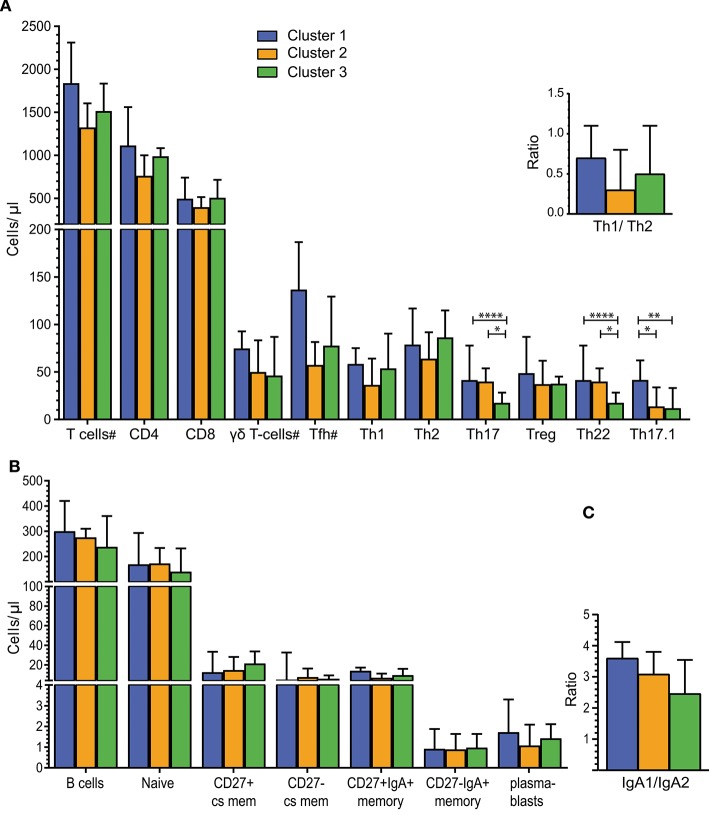
Alterations in Th cell subsets in individuals with distinct intestinal microbiota. (A) Absolute numbers of total T cells and T-cell subsets for Clusters 1 (n = 7), Cluster 2 (n = 7), and Cluster 3 (n = 20). Individuals per cluster differ for cell subsets marked with a “#” T cells: C1 = 7, C2 = 8, C3 = 20/CD4 and CD8 T cells: C1 = 7, C2 = 7, C3 = 20; γδT cells: C1 = 5, C2 = 8, C3 = 20 and Tfh: C1 = 4, C2 = 4, C3 = 11. Top right - Ratio of Th1 to Th2 cells. (B) B-cell counts for total B-cells and B-cell subsets for Clusters 1 (n = 7), Cluster 2 (n = 7) and Cluster 3 (n = 19). (C) Ratio of IgA1+/ IgA2+ B-cells for Cluster 1 (n = 5), Cluster 2 (n = 6), and Cluster 3 (n = 18). Bars in A-C represent median values with interquartile ranges. Statistics were calculated using the Mann-Whitney U test: *P < 0.05; **P < 0.01; ****P < 0.0001.